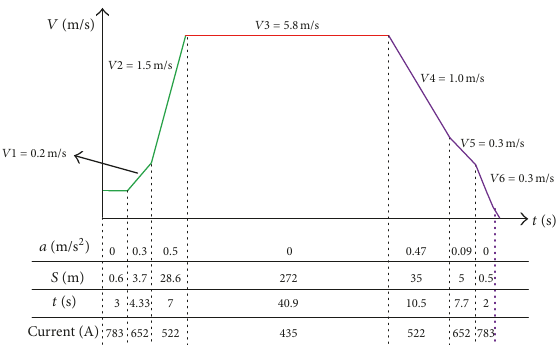
Figure 8: Lifting conditions of mine hoist in one cycle.